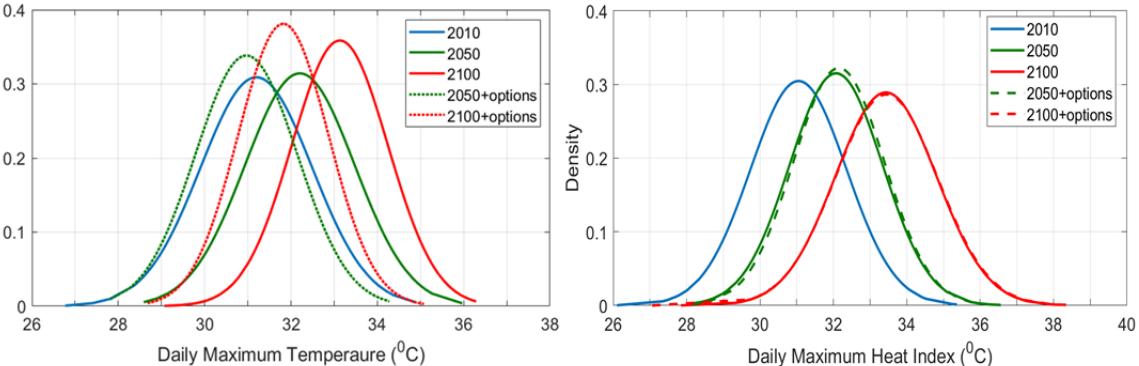
Figure 8. PDF of mean daily maximum temperature ( left ) and mean peak heat index ( right ) for the densely packed region of